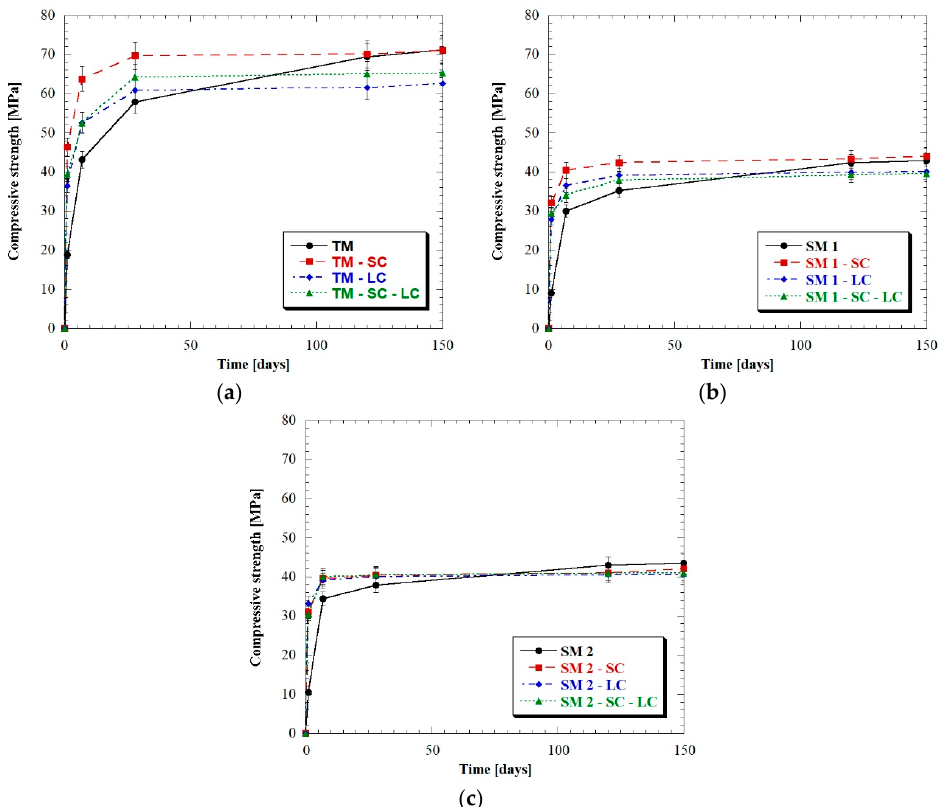
Figure 4. Compressive strength development of mortar ( a ) TM, ( b ) SM1 and ( c ) SM2 with different admixtures.